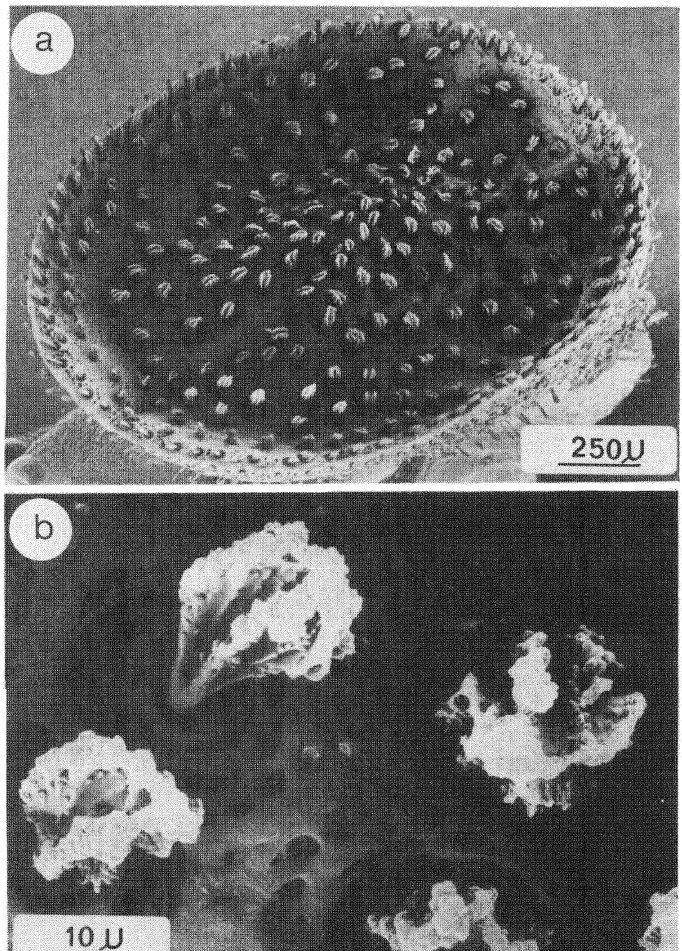
Fig. 7. Z. pallensporrasi (BCI, Panama). Clean soldier, a. Cephalic disc covered with brush setae, b. Close-up of large brush